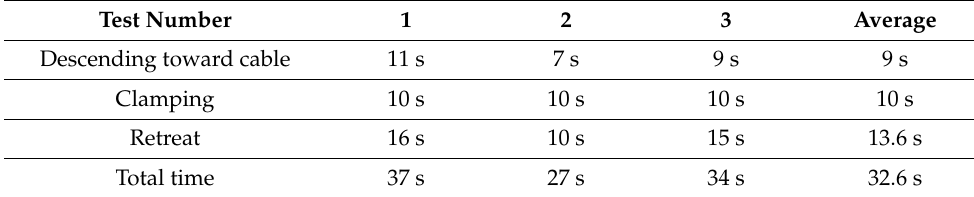
Table 1. The timing of the clip installation